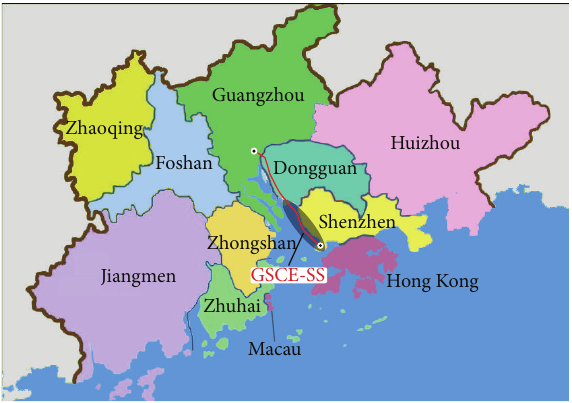
Figure 3: The location of GSCE-SS in Pearl River Delta